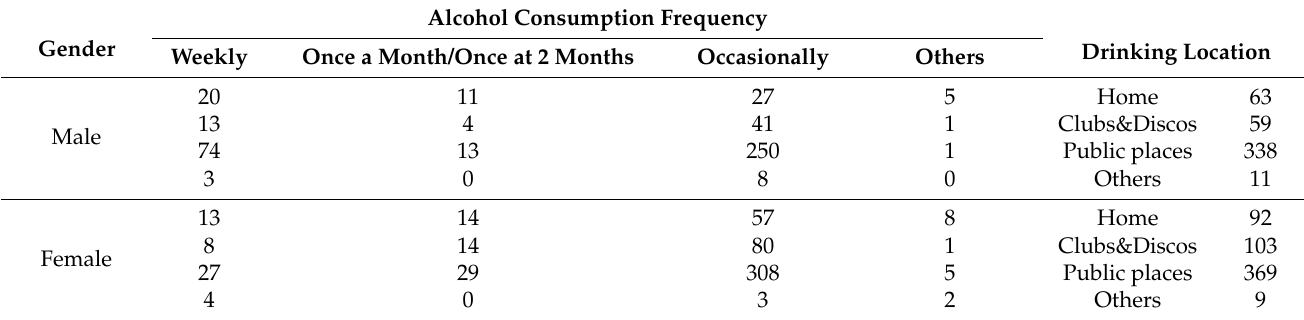
Table 4. The distribution of alcohol consumption frequency and location among male and female